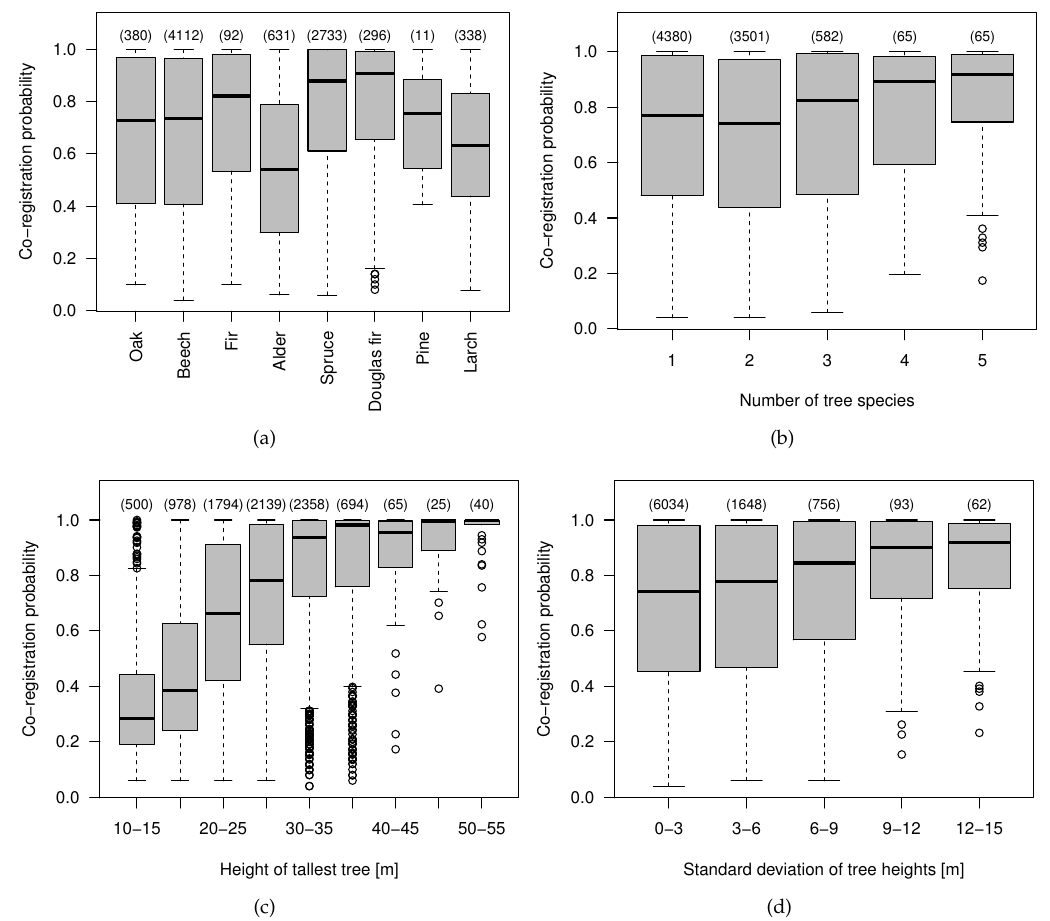
Figure 9. Effect of ( a ) the dominant tree species; ( b ) the number of tree species; ( c ) the height of the tallest tree; and ( d ) the variability of the tree heights on the probability of a correct co-registration. The numbers in brackets correspond to the number of plots. The whiskers extend to 1.5 times the interquartile range. Outliers are marked by